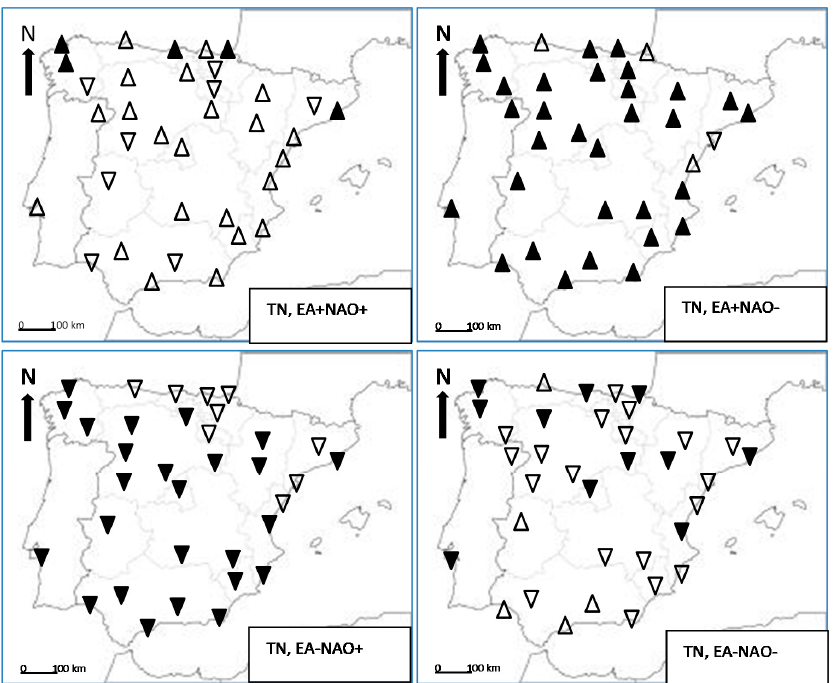
Figure 4. Difference of TN mean values for each EA-NAO composite and the mean of the complete period 1950–2019 for winter. Triangle up (down) means positive (negative) difference, full (empty) triangle means significant (not significant) difference at the 95% confidence level.